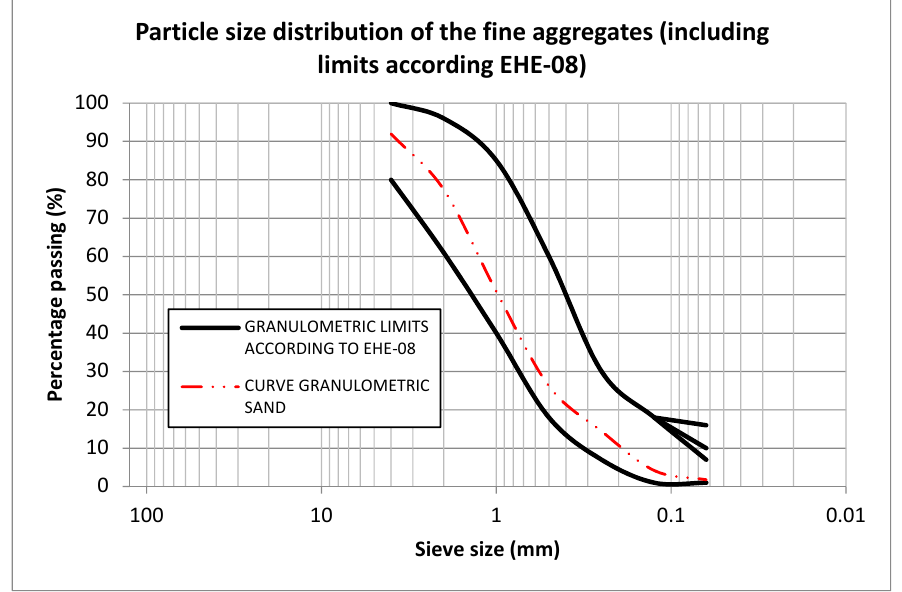
Figure 1. Particle size distribution of the fine aggregates used in the study, including limits according to EHE-08 (Spanish standard for concrete).